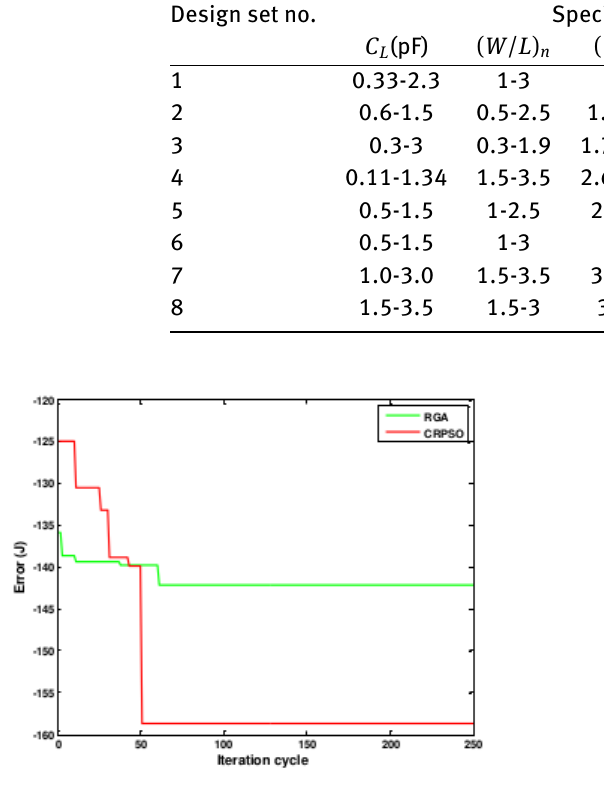
Figure 4: Plot of J versus iteration cycle for the seventh design set of Case study-1.